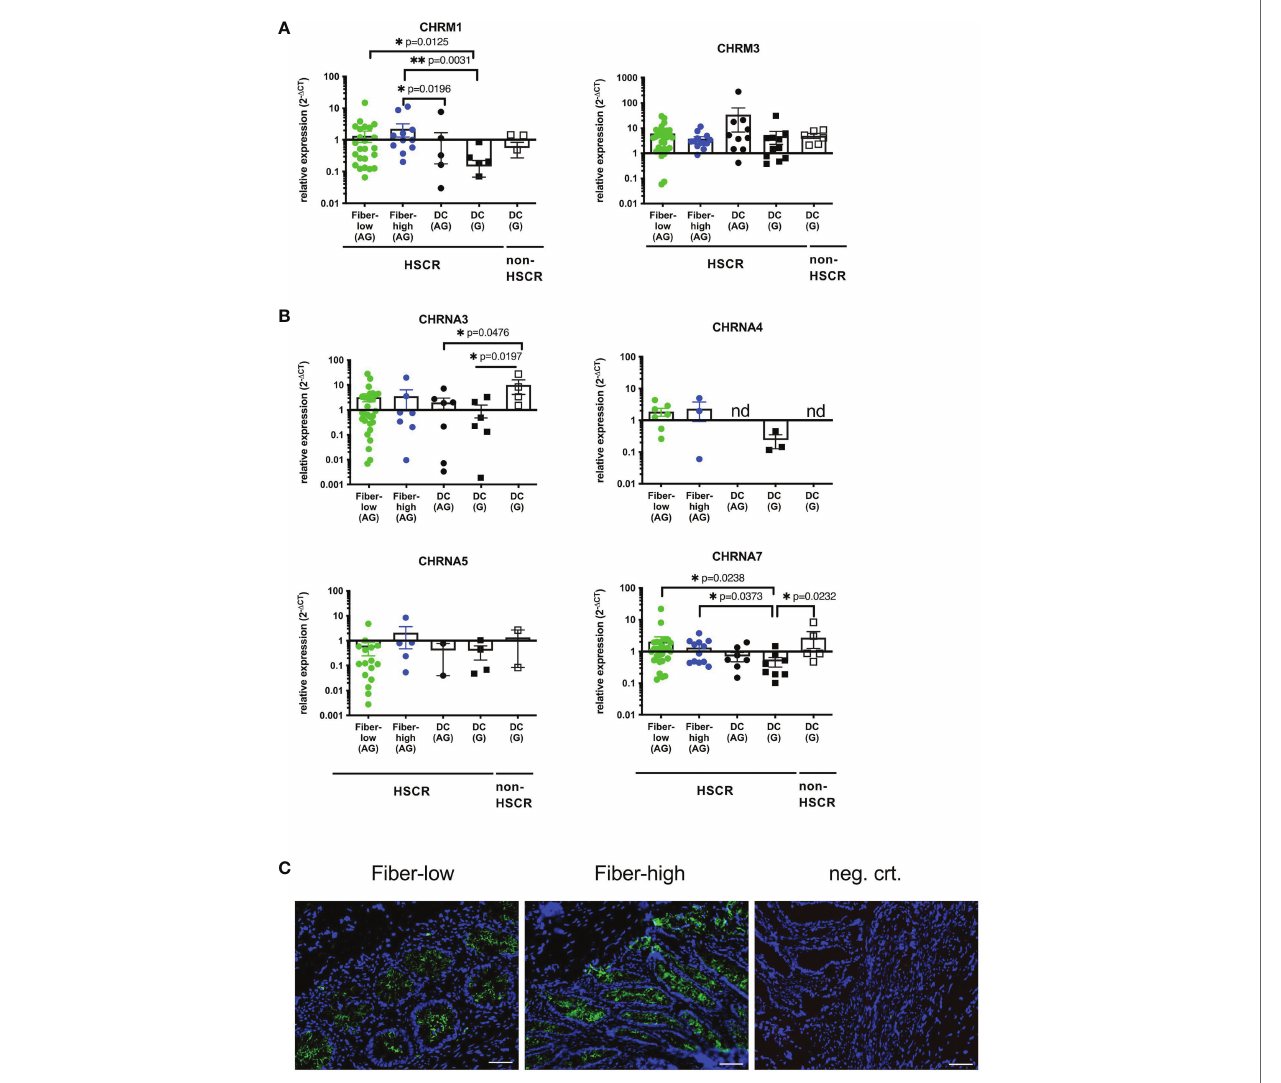
FIGURE 4 | Expression of IEC-speci fi c cholinergic receptors. Puri fi ed epithelial cells were immediately lysed, total RNA isolated and cDNA synthesized. Relative gene expression was calculated using the 2- D CT method, with b 2-microglobulin as the housekeeping gene (A, B) . Scatter plots with bar show mean ± SEM. Signi fi cance was determined using the Kruskal-Wallis test (*p ≤ 0.05, **p ≤ 0.01). Fiber-low (n=30); Fiber-high (n=13); DC AG (n=10); DC G, HSCR (n=12); DC G, non-HSCR (n=6). Not detectable samples: Fiber-low: CHRM1 (n=1); CHRNA3 (n=2); CHRNA4 (n=23); CHRNA5 (n=14); CHRNA7 (n=2). Fiber-high: CHRNA3 (n=6); CHRNA4 (n=10); CHRNA5 (n=8); CHRNA7 (n=1). DC AG: CHRNA3 (n=3); CHRNA4 (n=10); CHRNA5 (n=8); CHRNA7 (n=2). DC G, HSCR: CHRM1 (n=1); CHRM3 (n=1); CHRNA3 (n=6); CHRNA4 (n=9); CHRNA5 (n=8); CHRNA7 (n=4). DC G, non-HSCR: CHRNA3 (n=2); CHRNA4 (n=6); CHRNA5 (n=4); CHRNA7 (n=1). nd: not detectable. CHRNA7 Immuno fl uorescence (5µm cryosections) from fi ber-low and fi ber-high rectosigmoid using puri fi ed mouse IgG1 anti-alpha7nAchR antibody (green) (C) . DAPI (blue) shows cell nuclei. Secondary antibody goat anti-mouse IgG1 Alexa 555 was used as the negative control. Scale bar